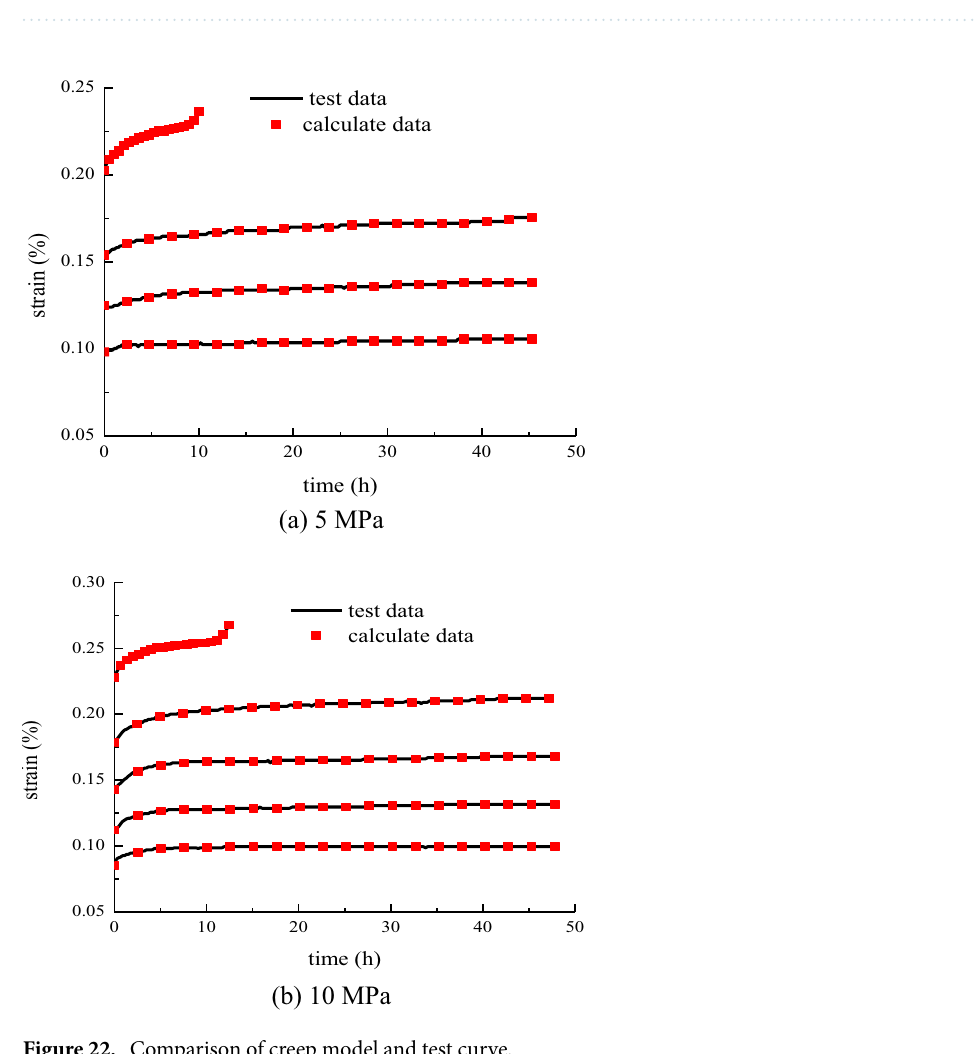
Figure 22. Comparison of creep model and test